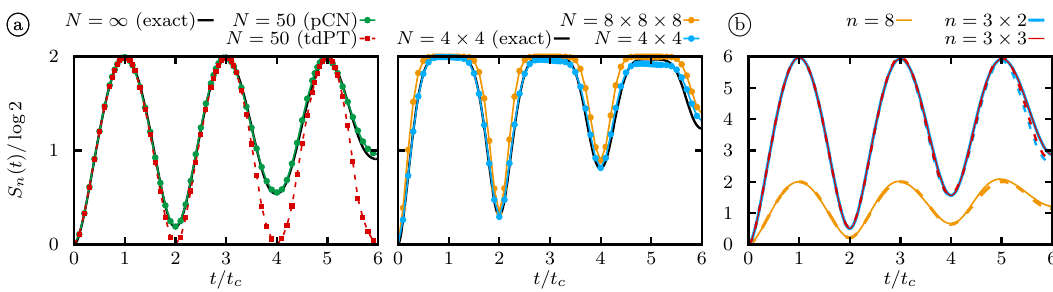
(a) Time evolution of the entanglement entropy for subsystems of n = 2 spins obtained from the classical network by MC in comparison with exact results; h / J = 0.05. (b) Time evolution of the entanglement entropy for different subsystem shapes with n spins obtained from full wave functions | ψ ( t ) 〉 determined from the pCN in comparison with exact results (dashed lines). In d = 1 the system size is N = 20, in d = 2 it is N = 6 × 3; h / J =